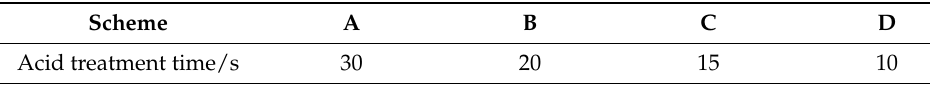
Table 2. Tool substrate surface pre-treatment